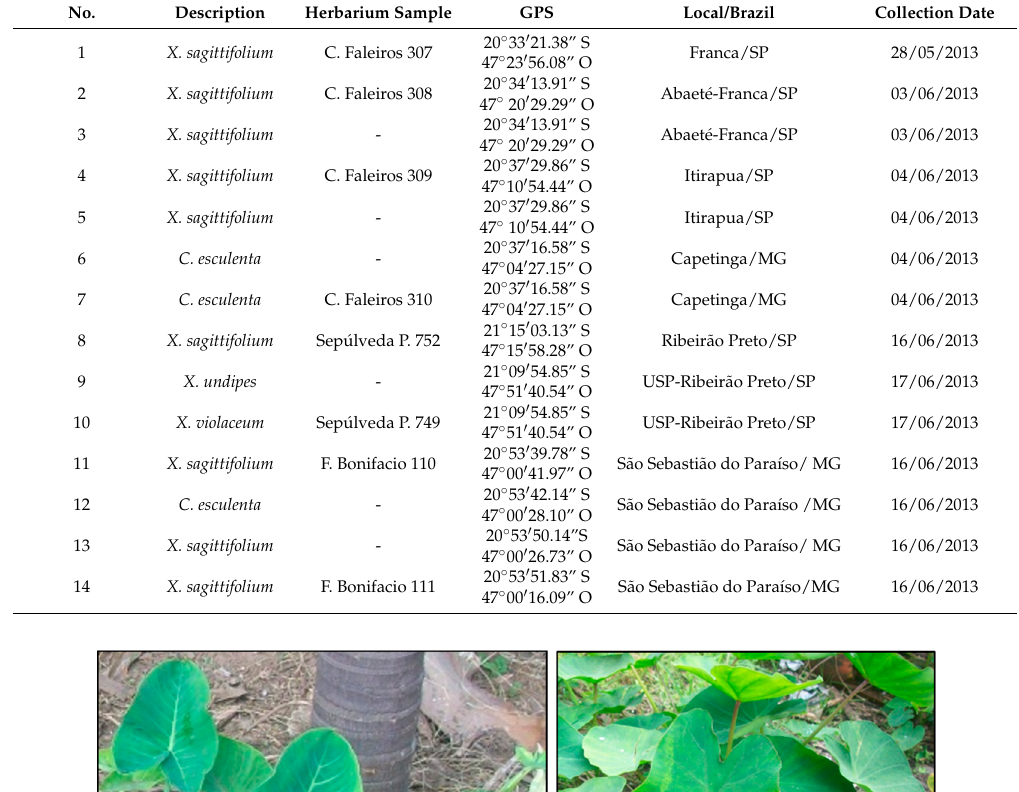
Table 1. Data of specimens studied.